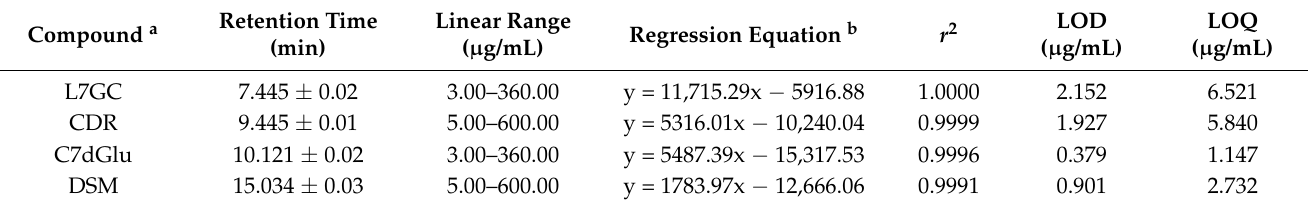
Table 1. Retention times, linear ranges, regression equations, coefficients of determination ( r 2 ), limits of detection (LODs), and limits of quantitation (LOQs) of L7GC, CDR, C7dGlu, and DSM for the developed HPLC-PDA method ( n = 6).